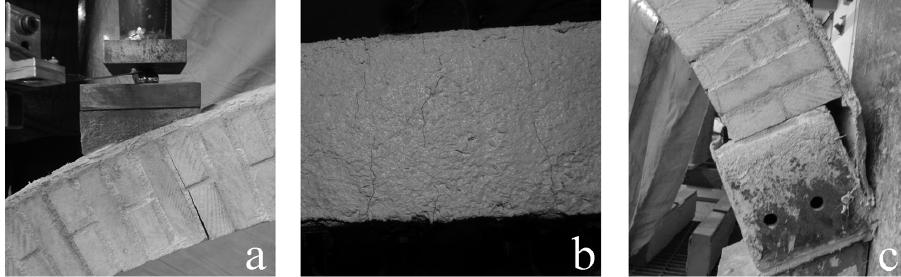
Figure 9. PBO ‐ FRCM ‐ strengthened arch: ( a ) hinge 1; ( b ) cracks in cementitious mortar matrix; ( c ) joint sliding at the right abutment [16].